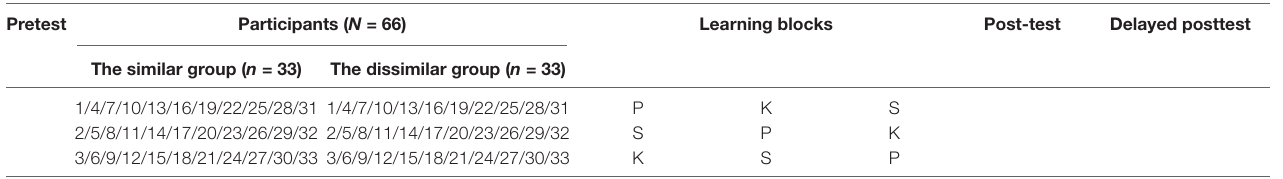
TABLE 2 | An experiment schedule and Latin square design used for balancing the order of learning strategies.